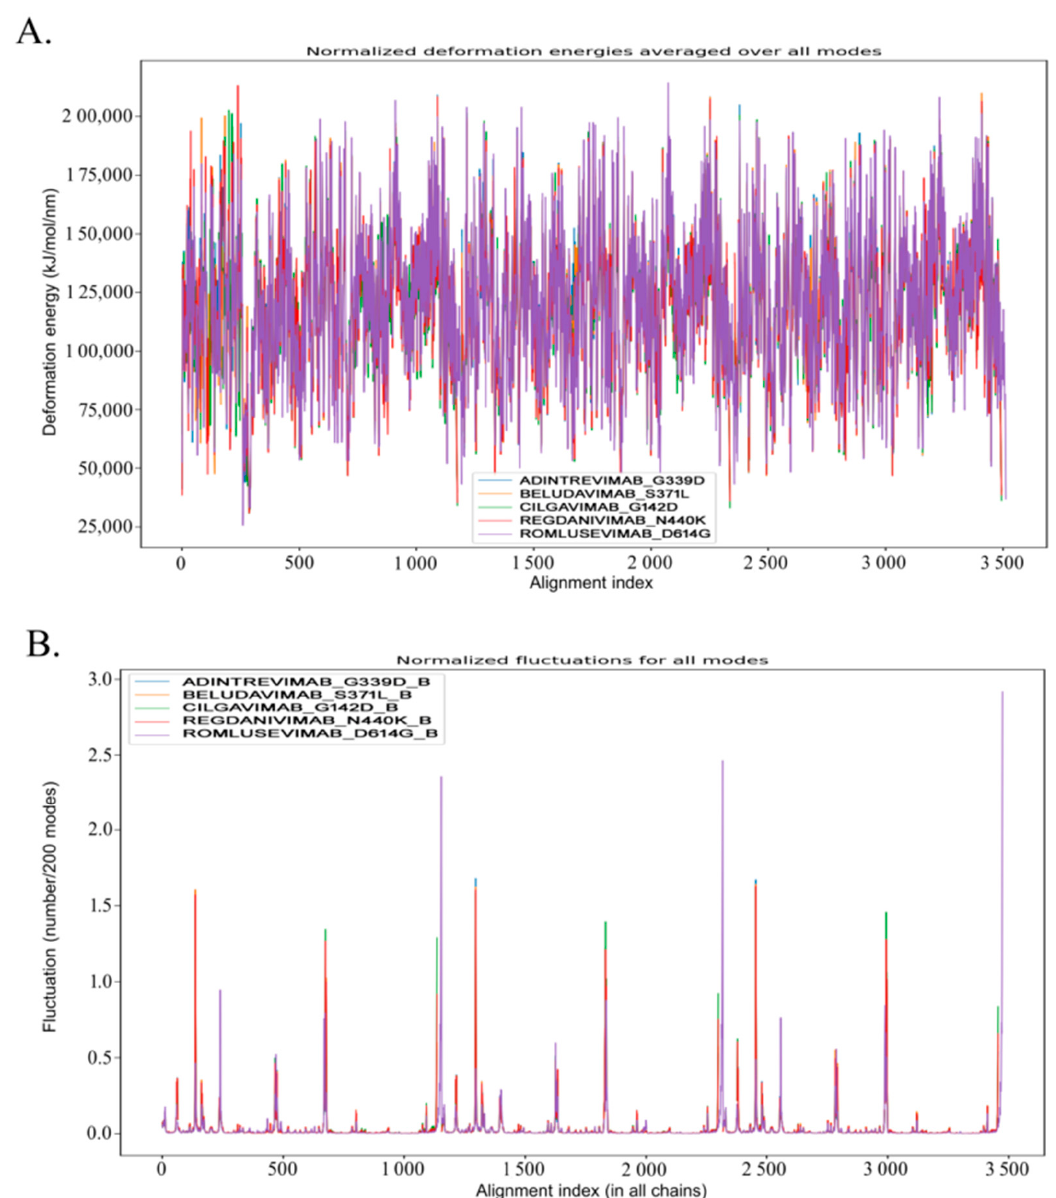
Figure 2. Analyses of the molecular dynamics of 5 mAb-Omicron spike protein complexes, adintrevimab_G339D, beludavimab_S371L, cilgavimab_G142D, regdanivimab_N440K, and romlusevimab_D614G, respectively. ( A ) Visualization of normalized deformation energies of 5 mAb–Omicron spike protein complexes. ( B ) Illustration of fluctuation details of the spike proteins of 5 mAb–Omicron spike protein complexes (Only B chain of the spike proteins was utilized to conduct the fluctuation study).